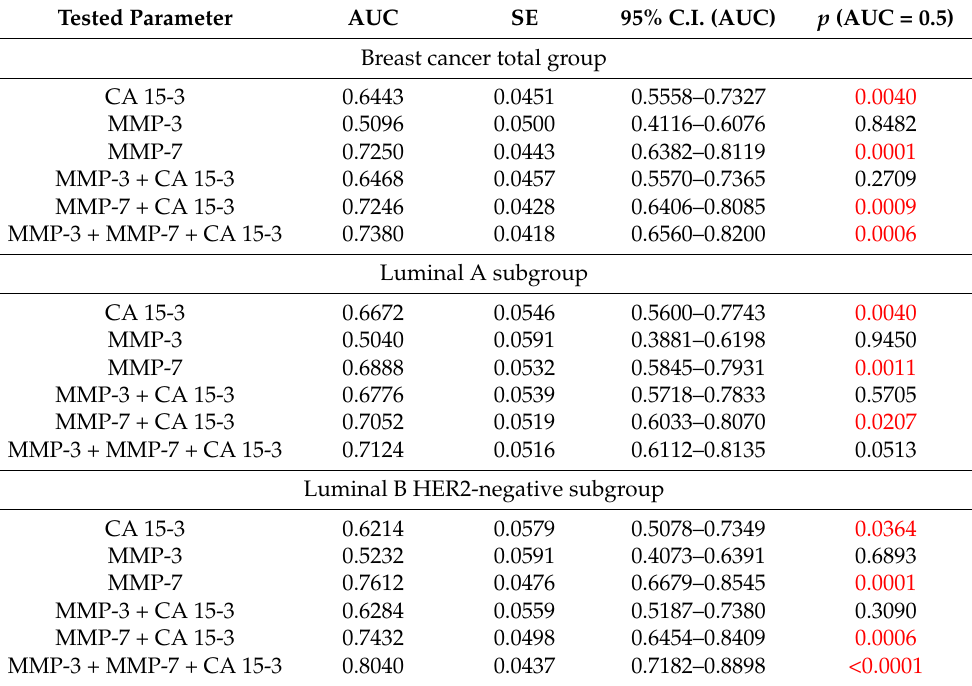
Table 6. Characteristics of ROC curve for tested parameters in patients with BC—total group and Luminal A and B subgroups. Tested Parameter AUC SE 95% C.I. (AUC) p (AUC = 0.5) Breast cancer total group CA 15-3 0.6443